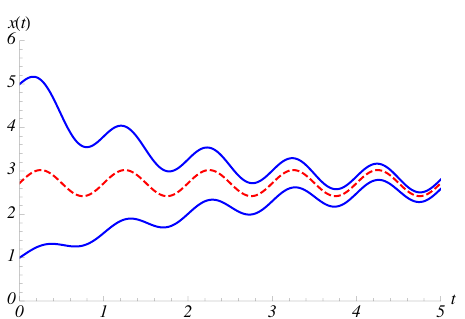
Figure 1. The deterministic curves x ( t ) , given in (1), with t 0 = 0, β = 0.6, ν ( t ) = ln [ e + 0.3 sin ( 2 π t )] and for x 0 = 1 and x 0 = 5 (solid blue curves); the dashed curve represents the carrying capacity e ν ( t ) .